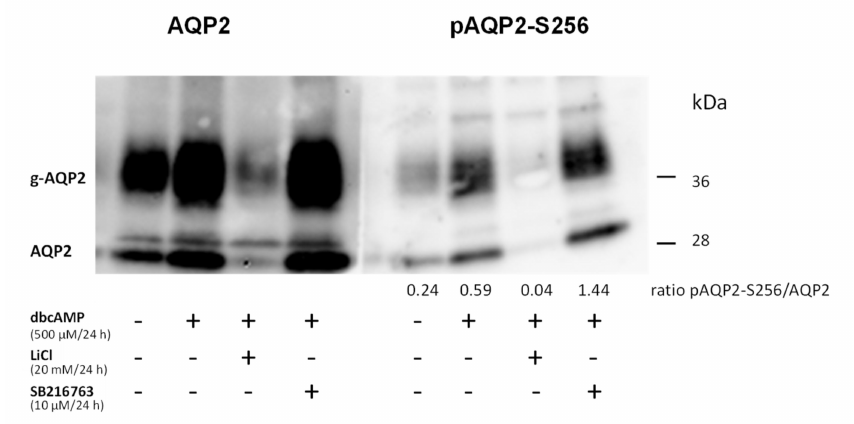
Figure 12. Treatment with dbcAMP prevents downregulation of Aqp2 by GSK3 α / β inhibition with SB216763. IMCD cells were left untreated, incubated with dbcAMP (500 µ M / 24 h) alone or together either with LiCl (20 mM / 24 h), or with the GSK3 inhibitor (SB216763, 10 µ M / 24 h). The expression of Aqp2 or of Aqp2 phosphorylated at position S256 (pAqp2-S256) was analyzed by Western blot analysis. The numbers indicate the relative p256-Aqp2 signal intensities compared to total Aqp2 (n =